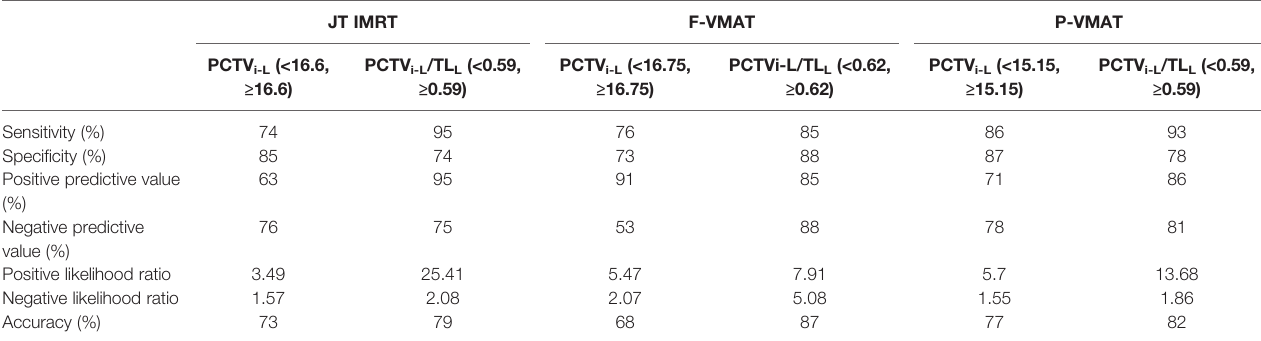
TABLE 4 | The sensitivity, speci fi city, positive and negative predictive value, positive and negative likelihood ratios, and accuracy of the cutoff points of JT IMRT, F-VMAT, and P-VMAT. JT IMRT F-VMAT P-VMAT PCTV i-L (<16.6, ≥ 16.6)